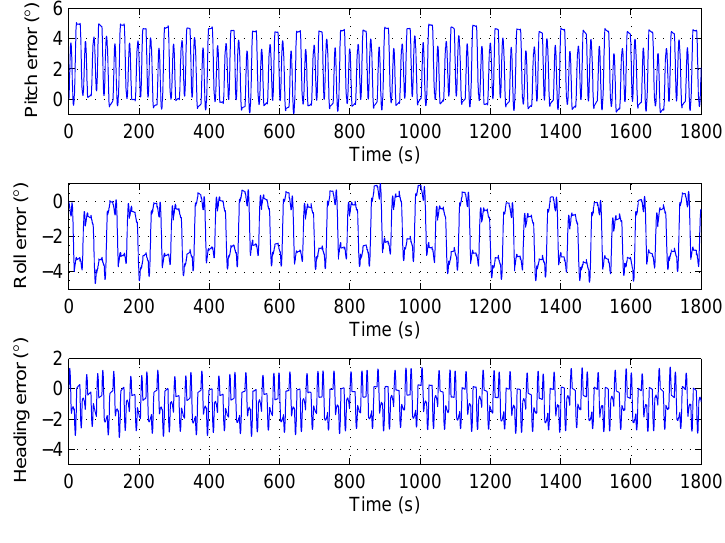
Figure 10. Attitude and heading errors of experiment 1 without installation error compensation.